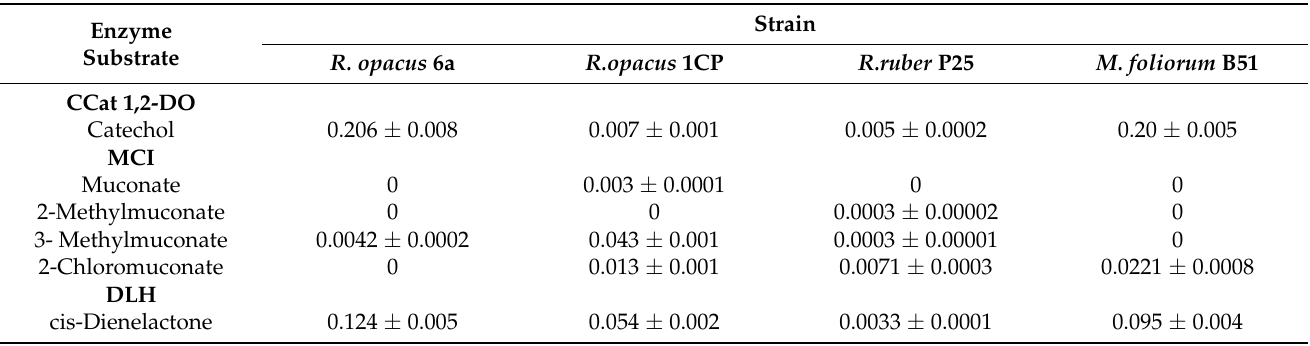
Table 2. Specific activities (Unit/mg of protein) of enzymes in cell-free extracts of strains grown in the presence of 3-CBA.